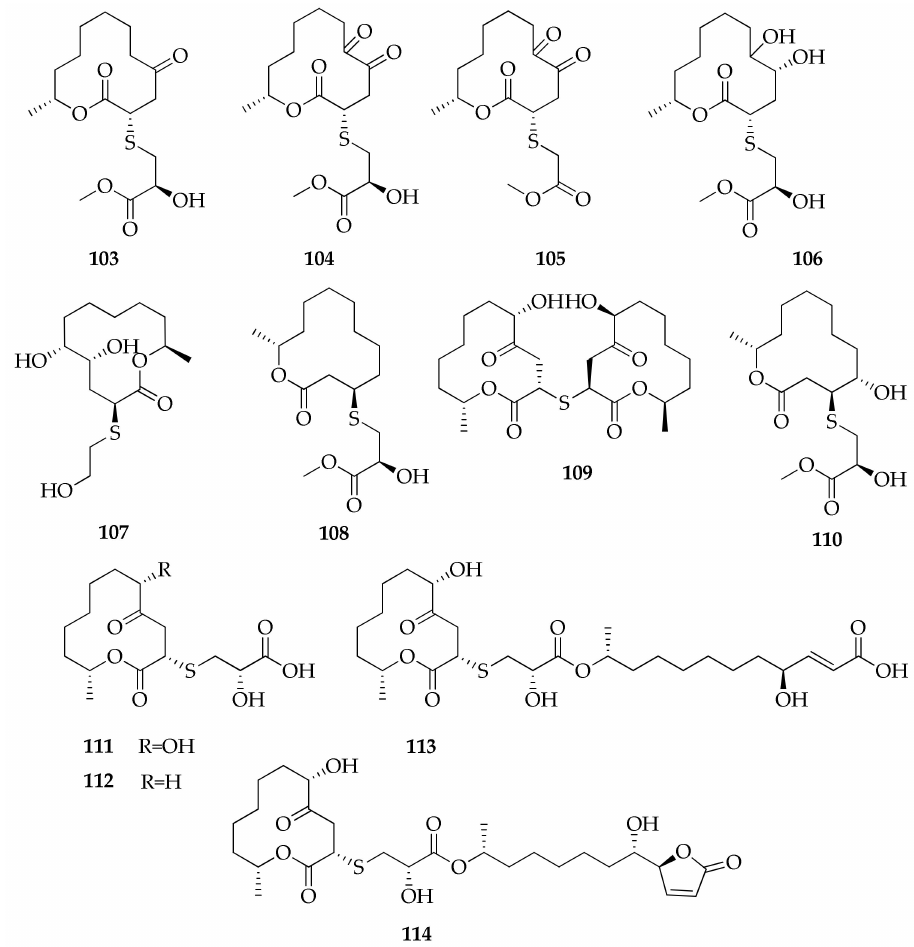
Figure 19. Structures of